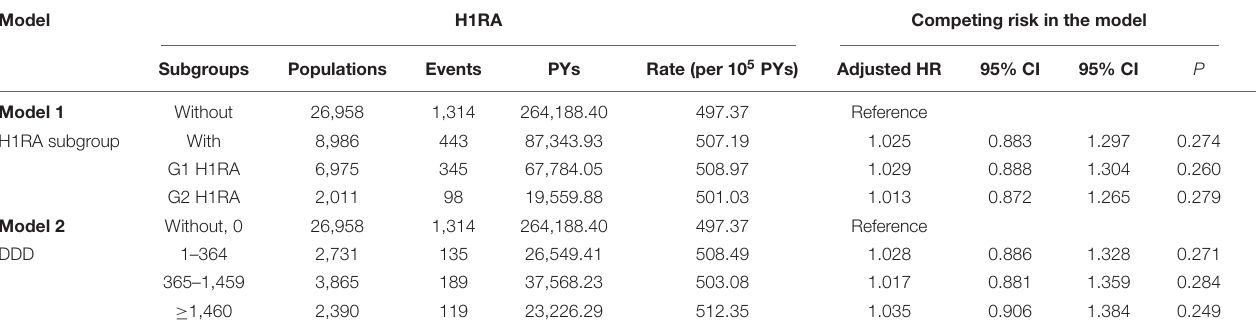
TABLE 3 | Factors of dementia in different model by using Cox regression with/without Fine and Gray’s competing risk model. Model